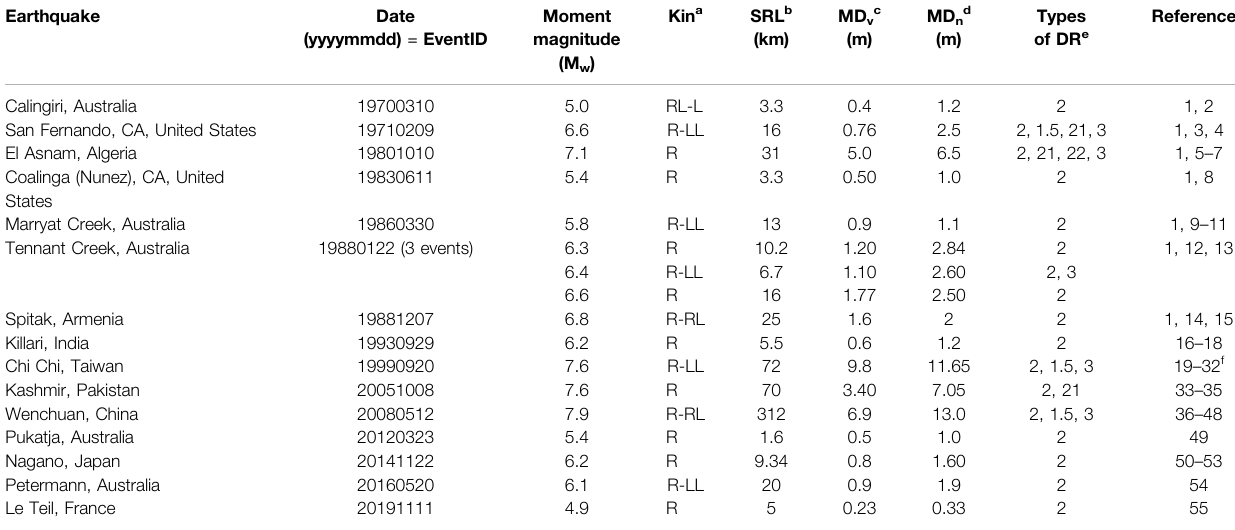
TABLE 1 | Reverse earthquakes included in the database. Earthquake Date (yyyymmdd) =